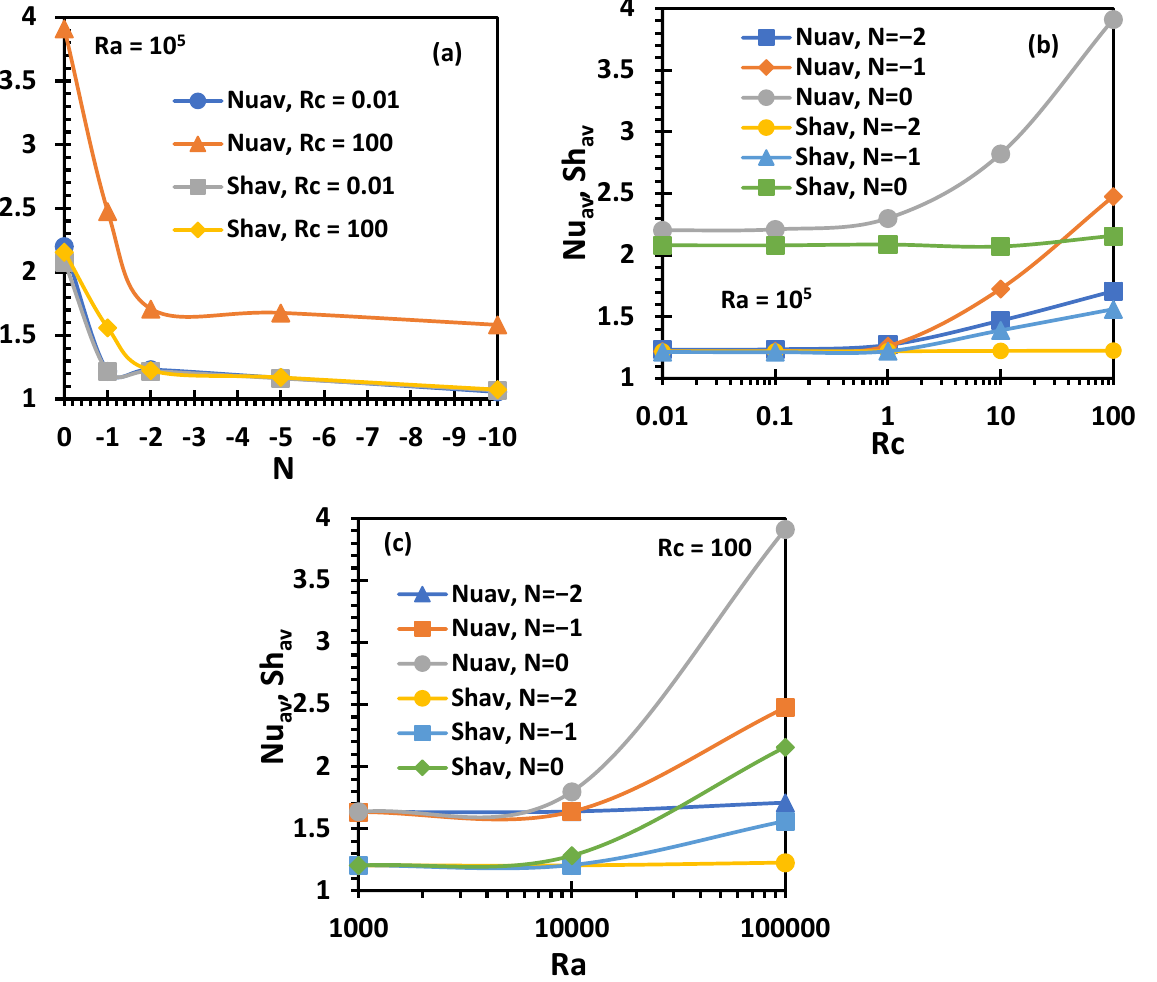
Figure 9. Variations of average Nusselt and Sherwood numbers; ( a ) versus N ; ( b ) versus ( Rc ) and ( c ) versus Ra .